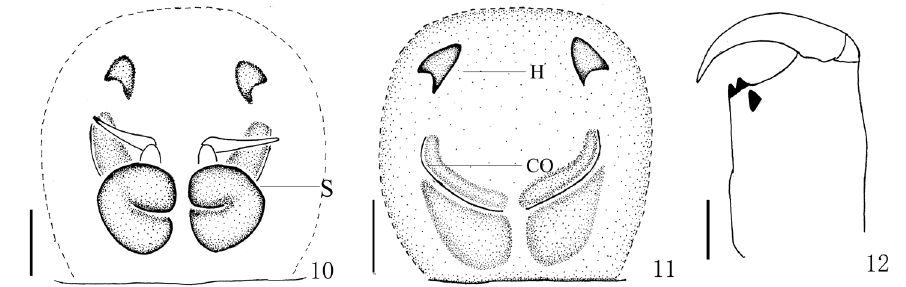
Figures 10–12. Yaginumaella lushuiensis sp. n. 10 vulva, dorsal view 11 epigynum, ventral view 12 left chelicera, posterior view. Scale bars: 0.1